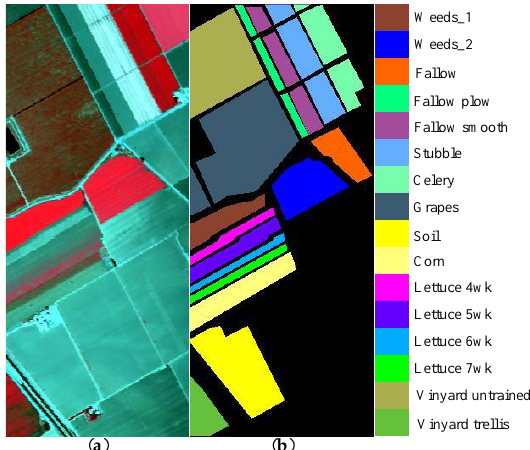
Figure 8. Salinas dataset. ( a ) Three-band false-color image. ( b ) Ground truth-map